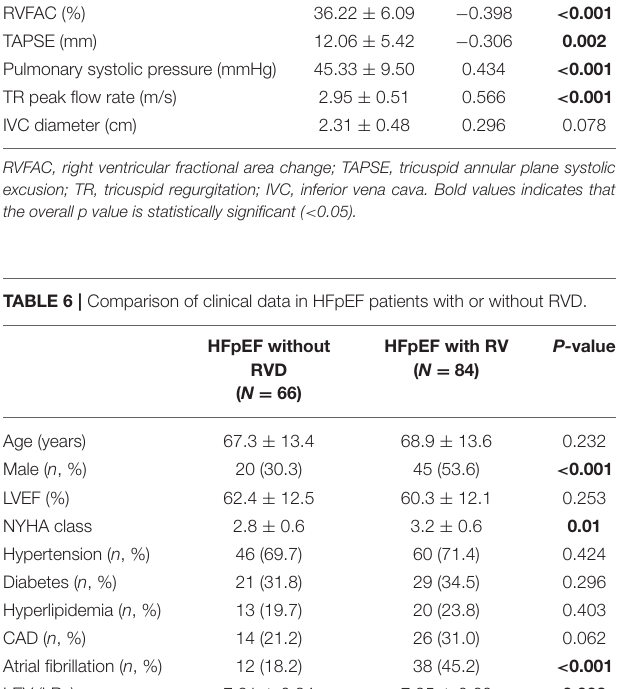
RVD, right ventricular dysfunction; LVEF, left ventricular ejection fraction; CAD, coronary artery disease; LEV, liver elasticity value. Bold values indicates that the overall p value is statistically significant ( < 0.05).